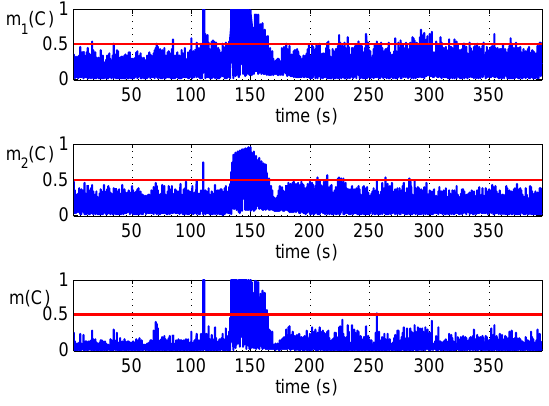
Figure 8. Detections fusion of the Scenario 2